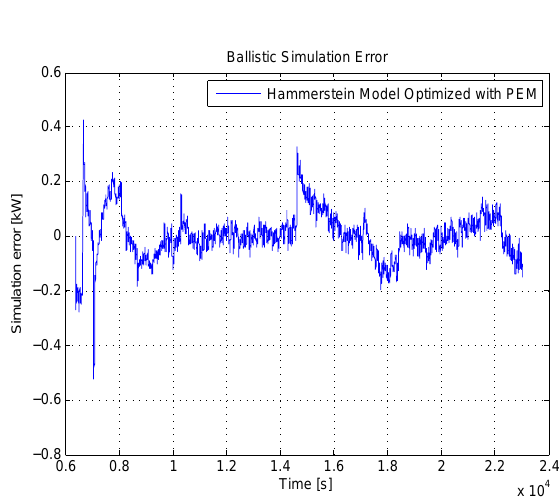
Figure 16: Ballistic simulation error of the final Ham- merstein